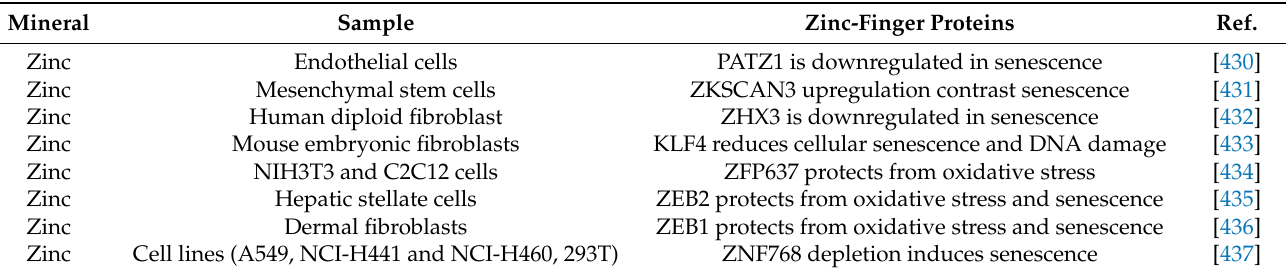
Table 6. Interplay between zinc-finger proteins and